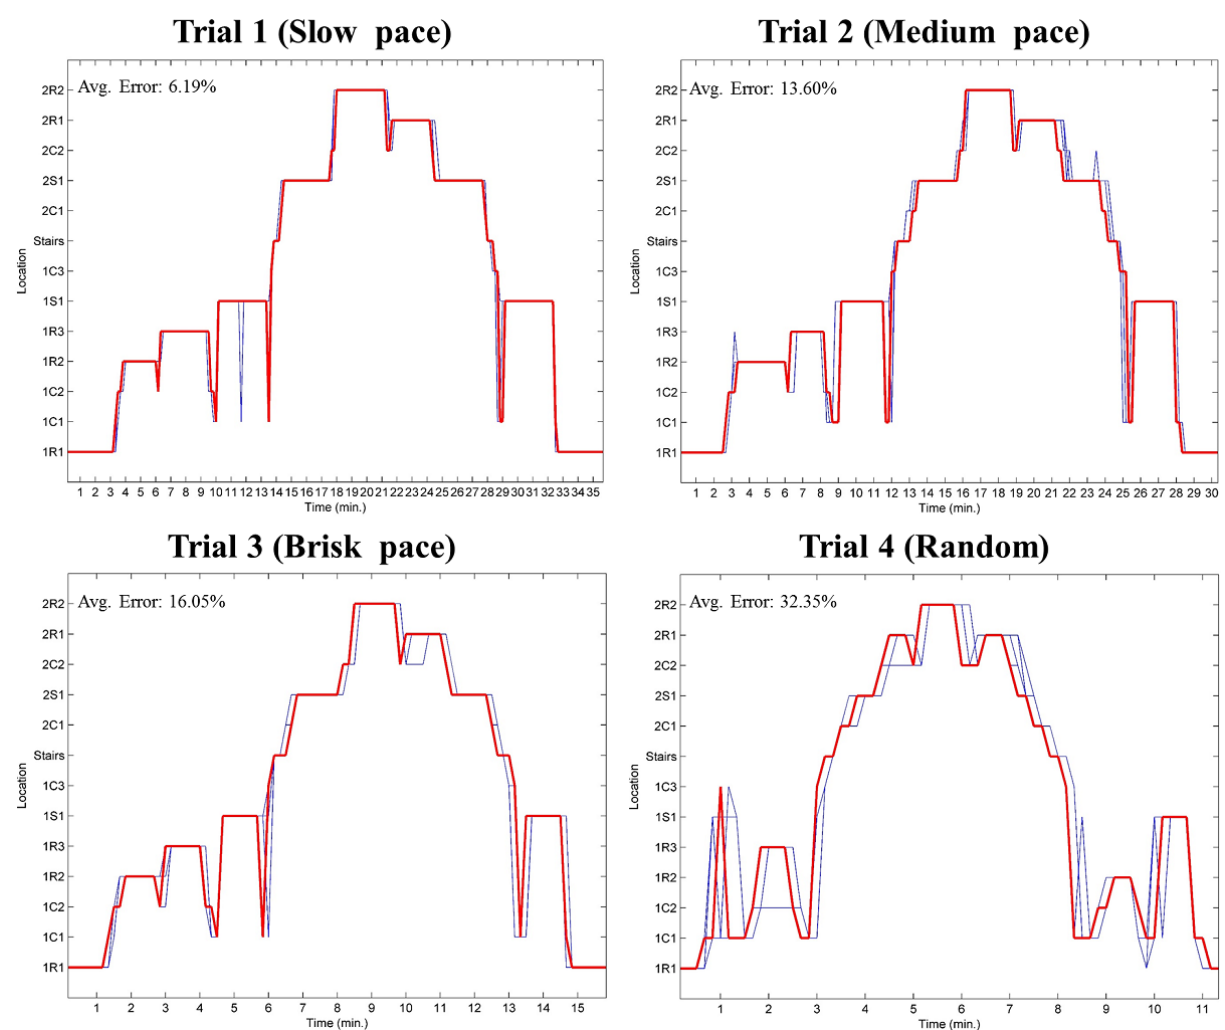
c Model 3: The connection weight among the beacons changes according to the step counts measurements but not for the corridors. Figure 5. Tracking quality graphs for trials 1-4 (model 3; w =1.0). The red line represents location derived from the criterion measurement (camera), and the blue lines represent the locations obtained from the